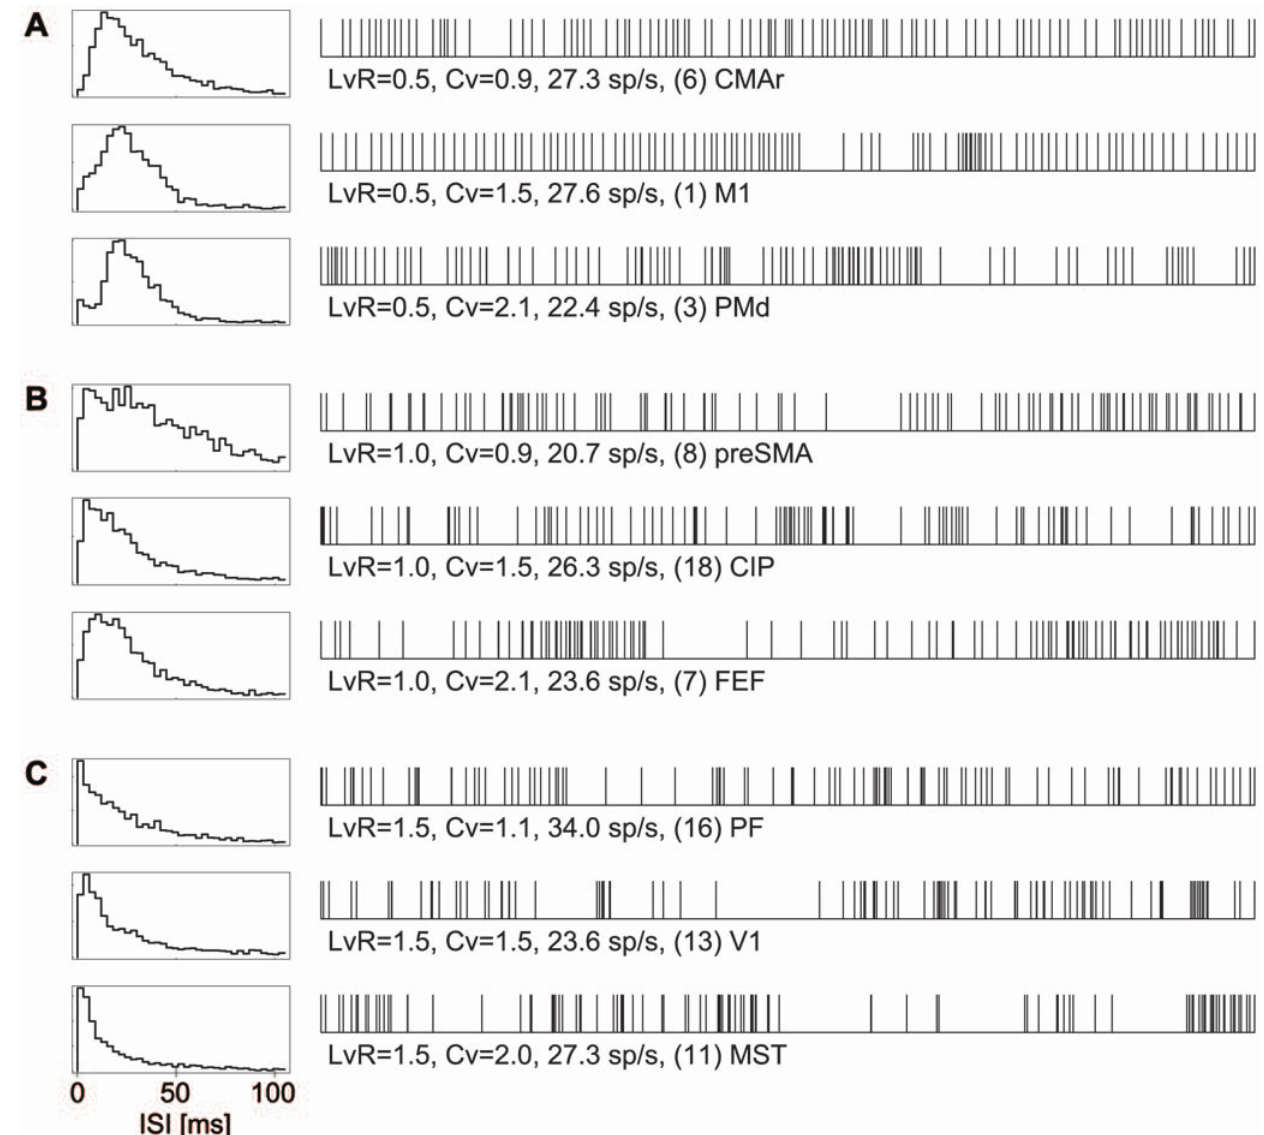
Figure 6. ISI distributions and sample firing patterns. (A), (B) and (C): Left: Distributions of 2,000 interspike intervals (ISIs) from neurons that exhibited LvR =0.5, 1.0, and 1.5, respectively. For LvR values, three neurons are sampled that exhibited different Cv values close to 1.0, 1.5, and 2.0. Right: Sample firing patterns consisting of 100 consecutive ISIs for each.